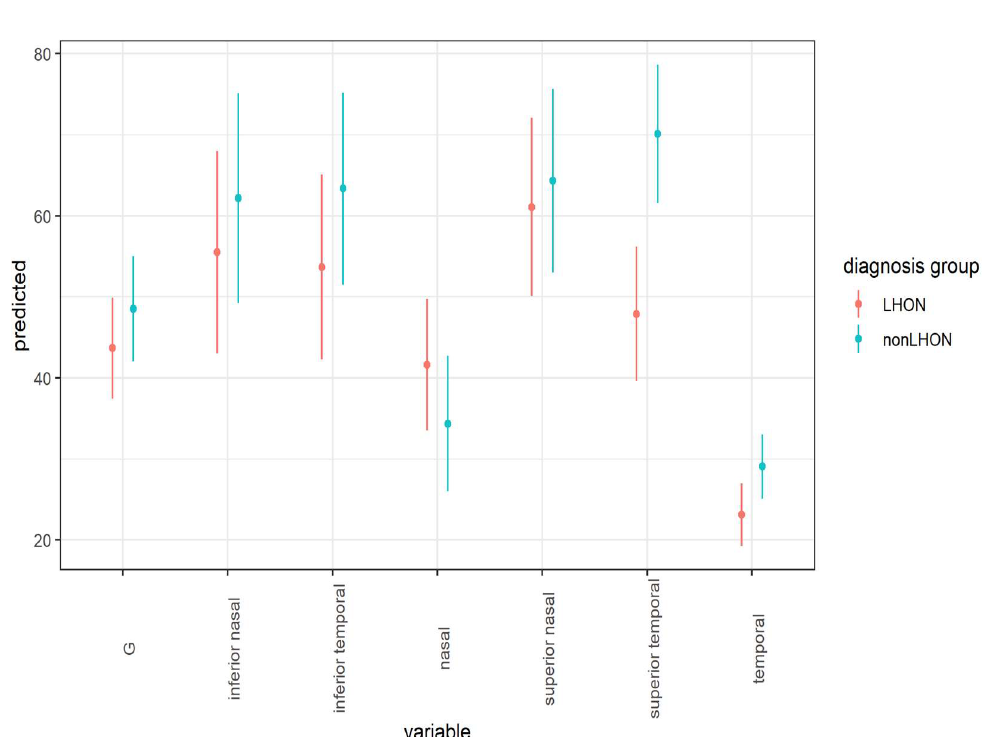
Figure 6. Predicted values for mean thickness (and 95 % confidence intervals) for RNFL layers for LHON and nonLHON group based on full model that includes participant’s ID as a random factor and diagnosis group as a fixed factor. Note thinner RNFL layer in superior temporal quadrant and thicker nasal RNFL in LHON group.